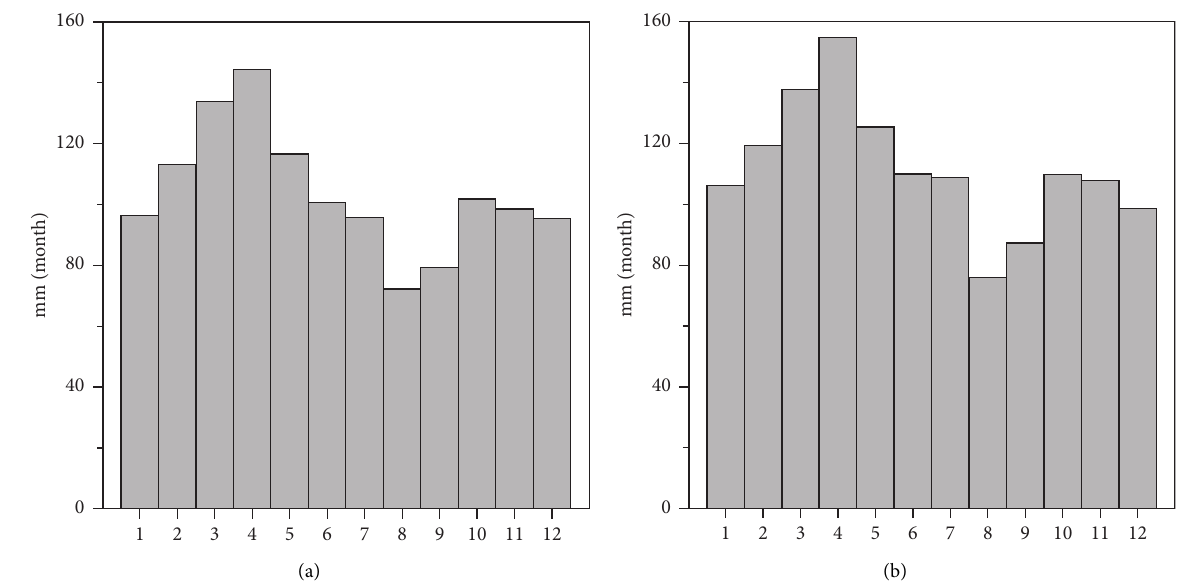
Figure 2: Seasonality of rainfall in (a) Labrado and (b) Chirimachay